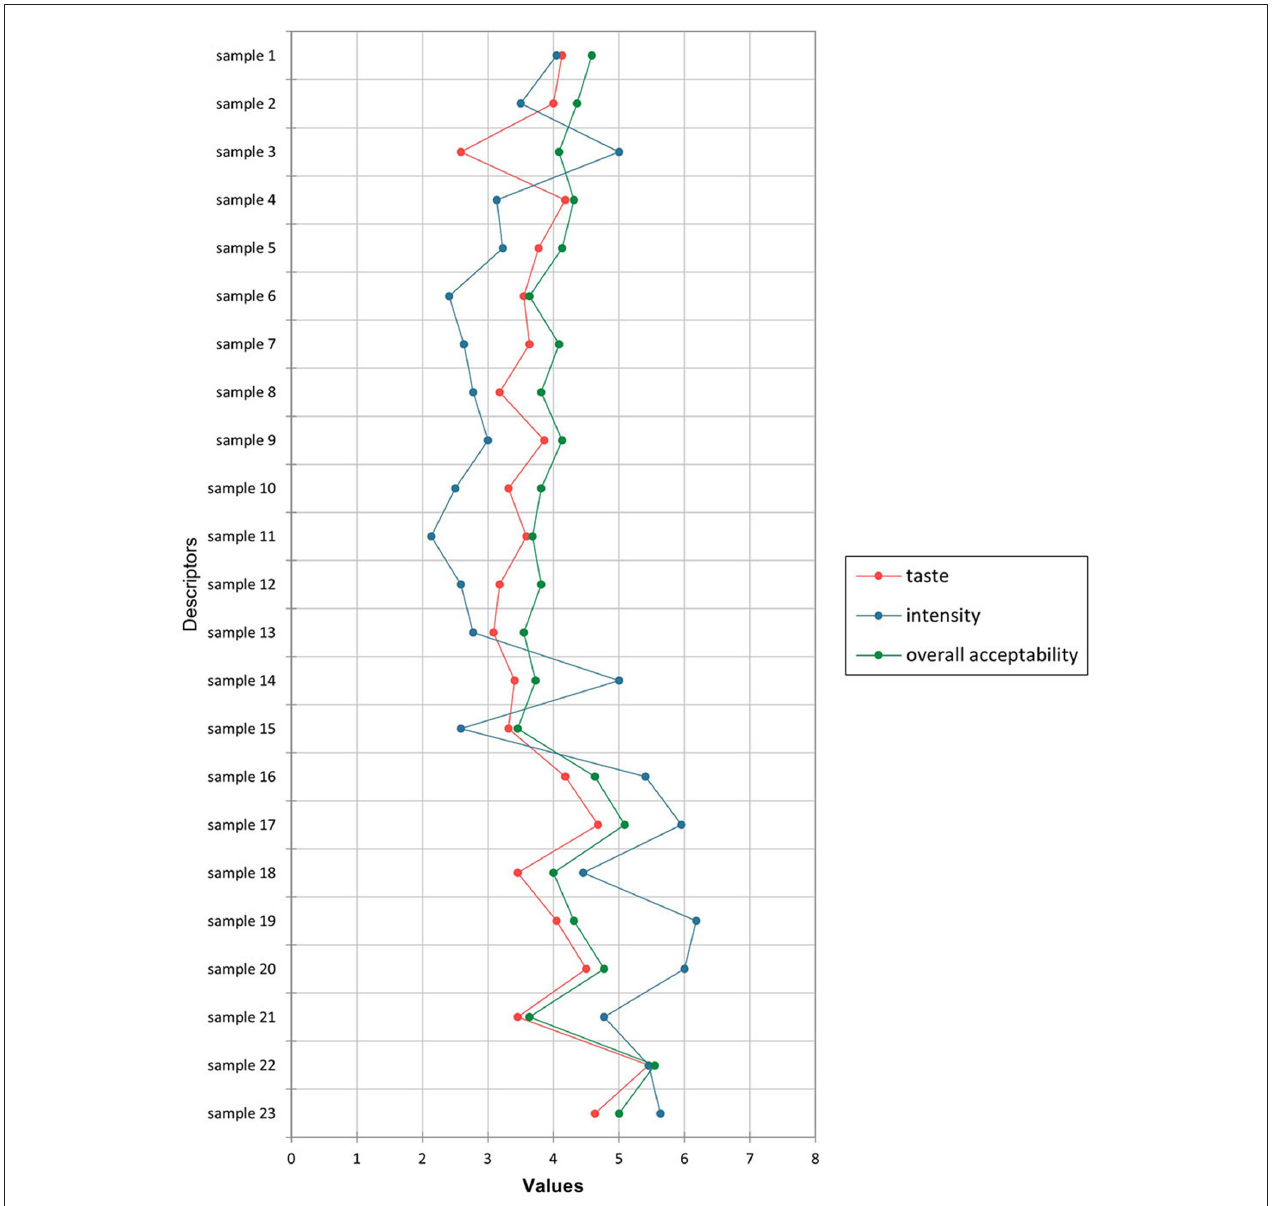
FIGURE 1 | Evaluation of taste, intensity, and overall acceptability of edible food